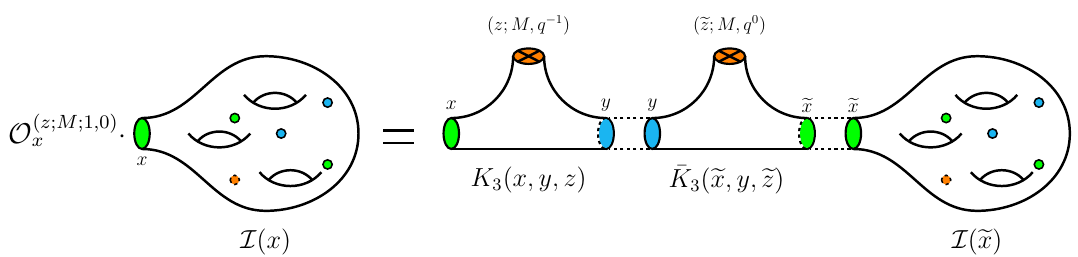
Figure 5: Construction of the A ∆ O. We start here with some theory with the super- conformal index I ( x ) . Then we S glue it to two trinions and close minimal punctures. In the figure above we close SU ( 2 ) punctures and denoted closure operation as the z cross on top of the puncture. The notation ( z ; M , q − 1 ) means that we close z -puncture by giving vev to the moment map M . The last label, q − 1 , denotes which kind of vev it is. In particular q 0 corresponds to constant vev, while non-zero negative powers, like q − 1 , correspond to the space dependent vev. As the result of gluing operation we obtain theory with the very same superconformal index I ( x ) but this time with some A ∆ O O ( z ; M ;1,0 ) acting on it. Particular form of operator depends on the x